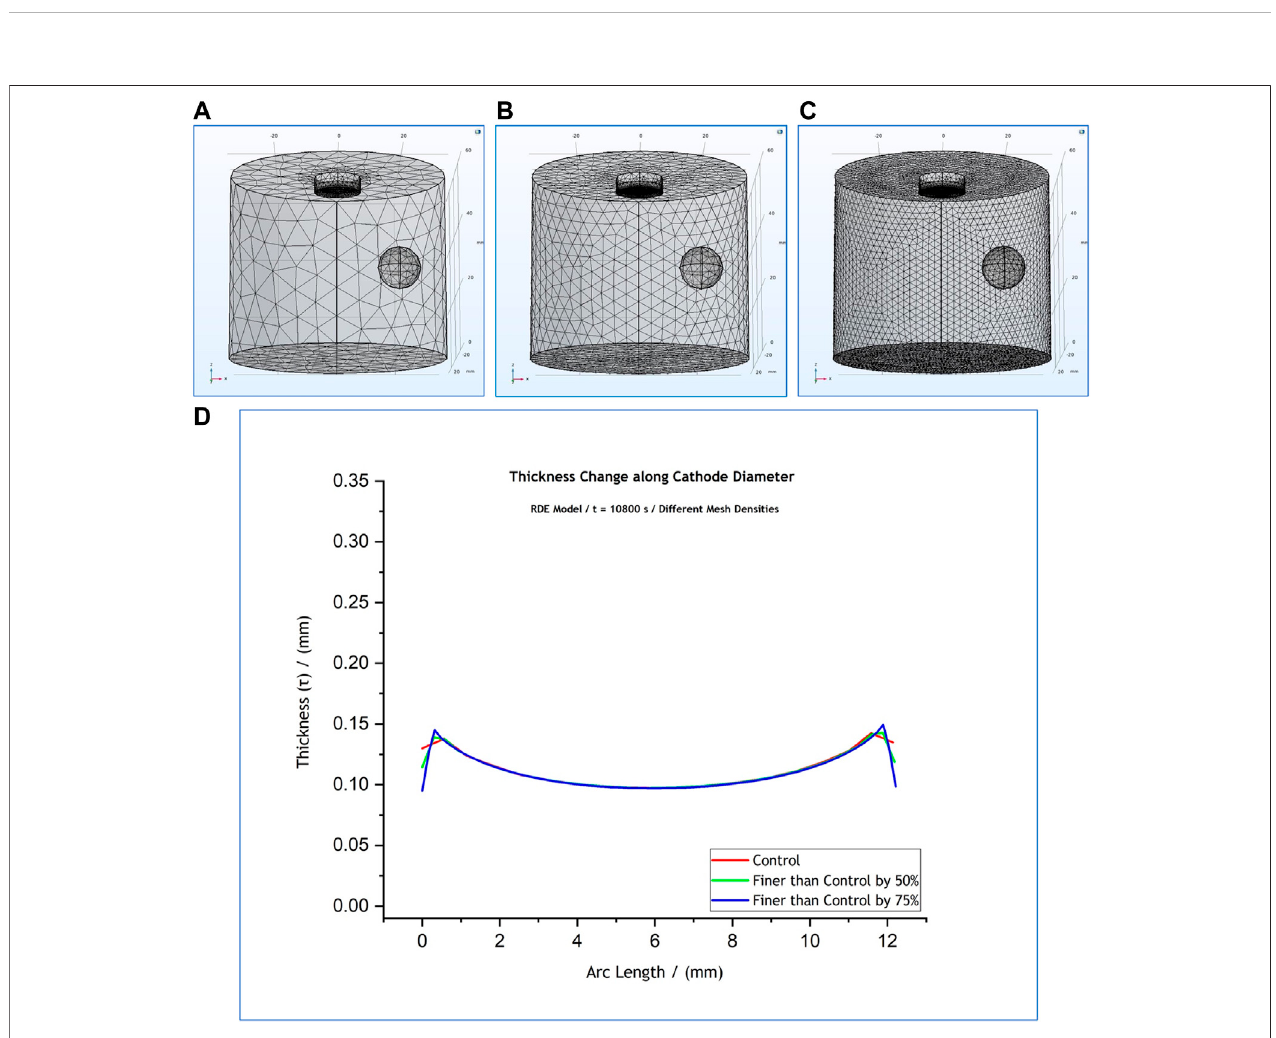
FIGURE5|(A) Controlmeshdensity(red), (B) meshspacing fi nerthanthecontrolby50%(green), (C) meshspacing fi nerthanthecontrolby75%(blue).Figure (D) shows an overlap of the thickness pro fi les predicted by the RDE model for the different mesh densities. The results simulate a 3-h process at 50 ℃